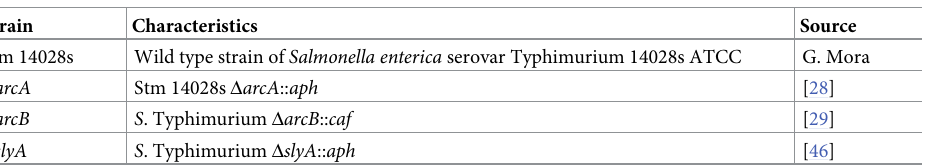
Table 1. Bacterial strains used in this